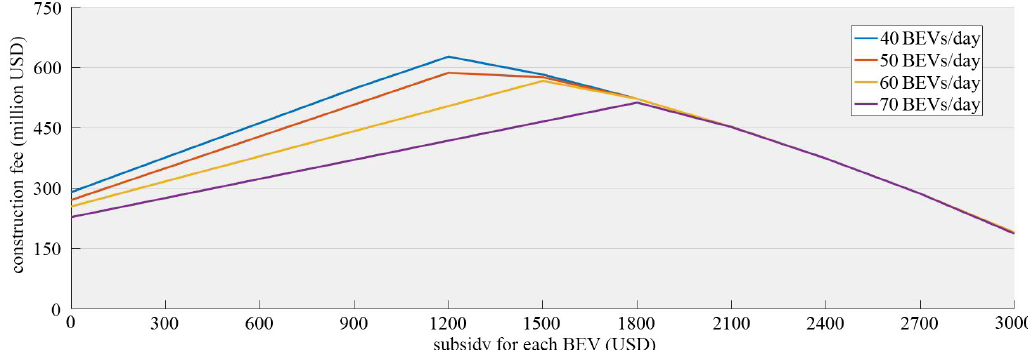
Figure 11. The total construction fees under different capacities of the charging piles and subsidies. Table 1. The best arrangements of the budget under each capacity.